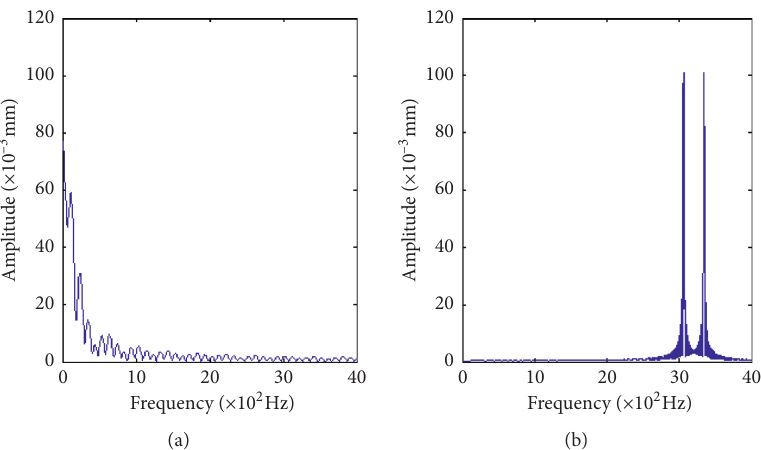
Figure 7: Frequency domain of the dynamic cutting forces at the depth of cut ( a � 0 . 005 mm), cutting speed ( V � 400mm/min. (a) Tangential component. (b) Normal component. velocity V w